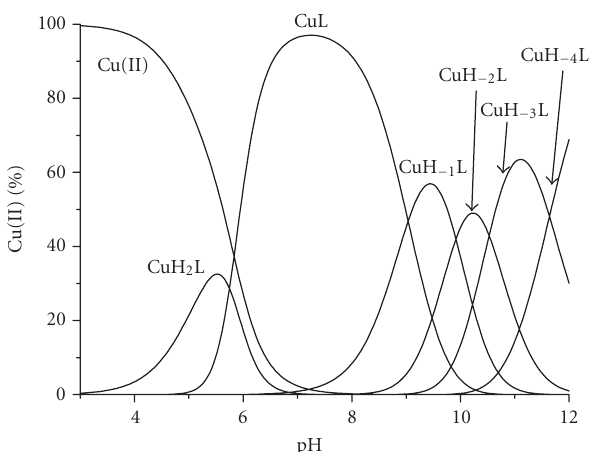
Figure 1: Species distribution diagram of Cu(II) complexes with -LAHYNK- (1 : 1), C peptide = 2mM.